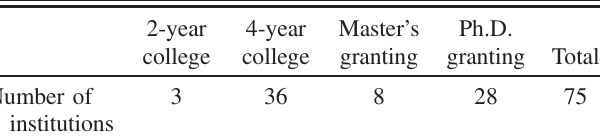
TABLE I. Number of institutions pre- and post instruction responses to the E-CLASS.